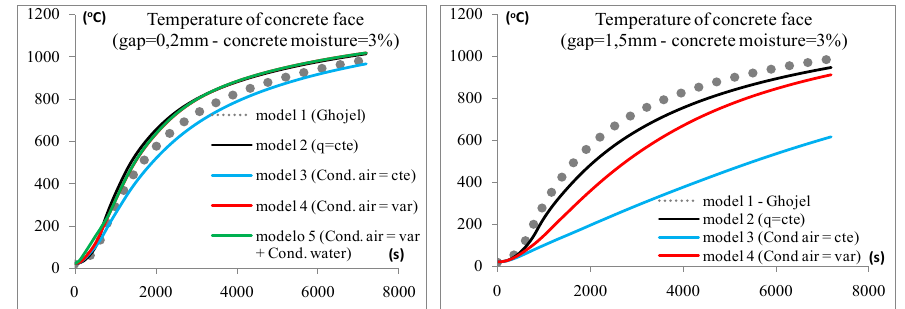
Figure 11. Temperature of concrete face according to the gap (3% concrete moisture).